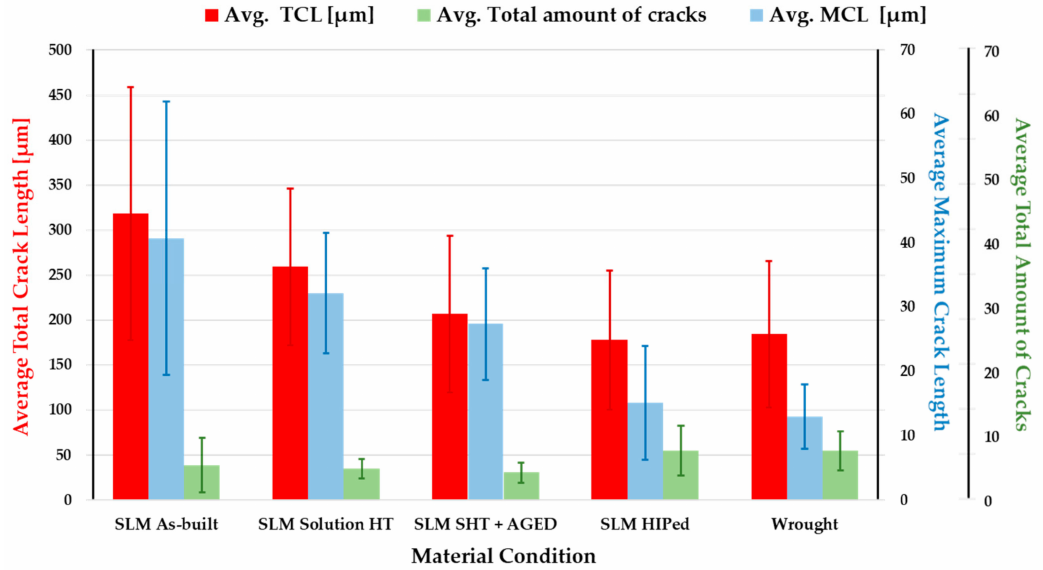
Figure 8. Heat a ff ected zone (HAZ) cracking susceptibility of SLM-manufactured Alloy 718 in comparison with wrought Alloy 718, presented as the average of total crack length measurements, average of maximum crack length, and total number of cracks (for five observations, with standard